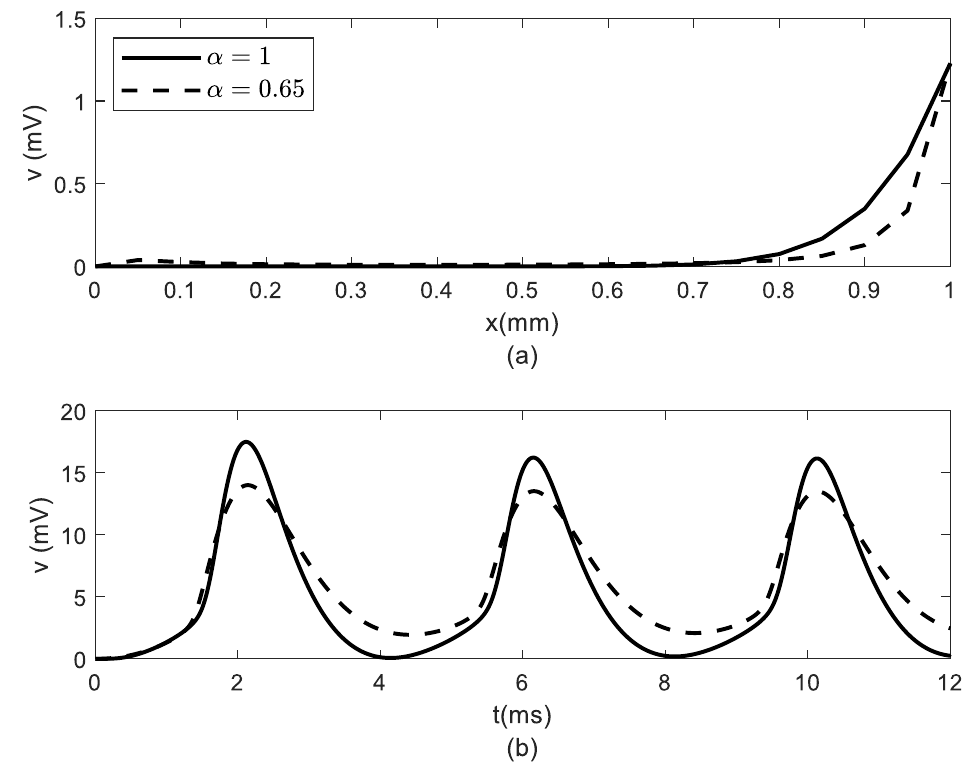
Figure 6. Profiles of 𝒗(𝒙,𝒕) at (a) 𝒕 = 𝟎. 𝟏 𝒎𝒔 and (b) 𝒙 = 𝟓𝟎𝟎 𝝁𝒎 . The fixed time in part (a) is almost the time when 𝑽(𝒕) reaches its first pick (see Figure